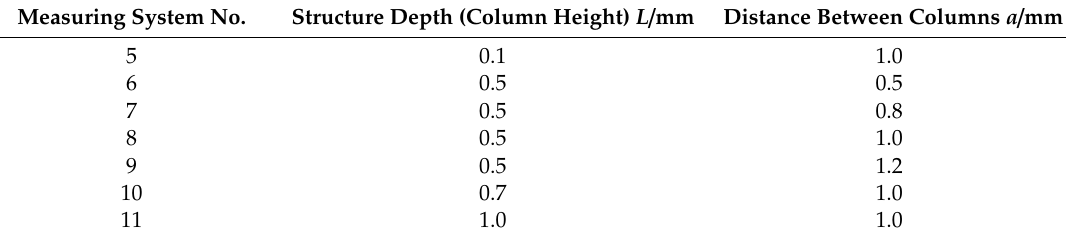
Table 3. Geometric dimensions of the bars, 𝑅 = 15 mm . Table 2. Geometric dimensions of the columnar structure, R = 12.5 mm. Measuring System